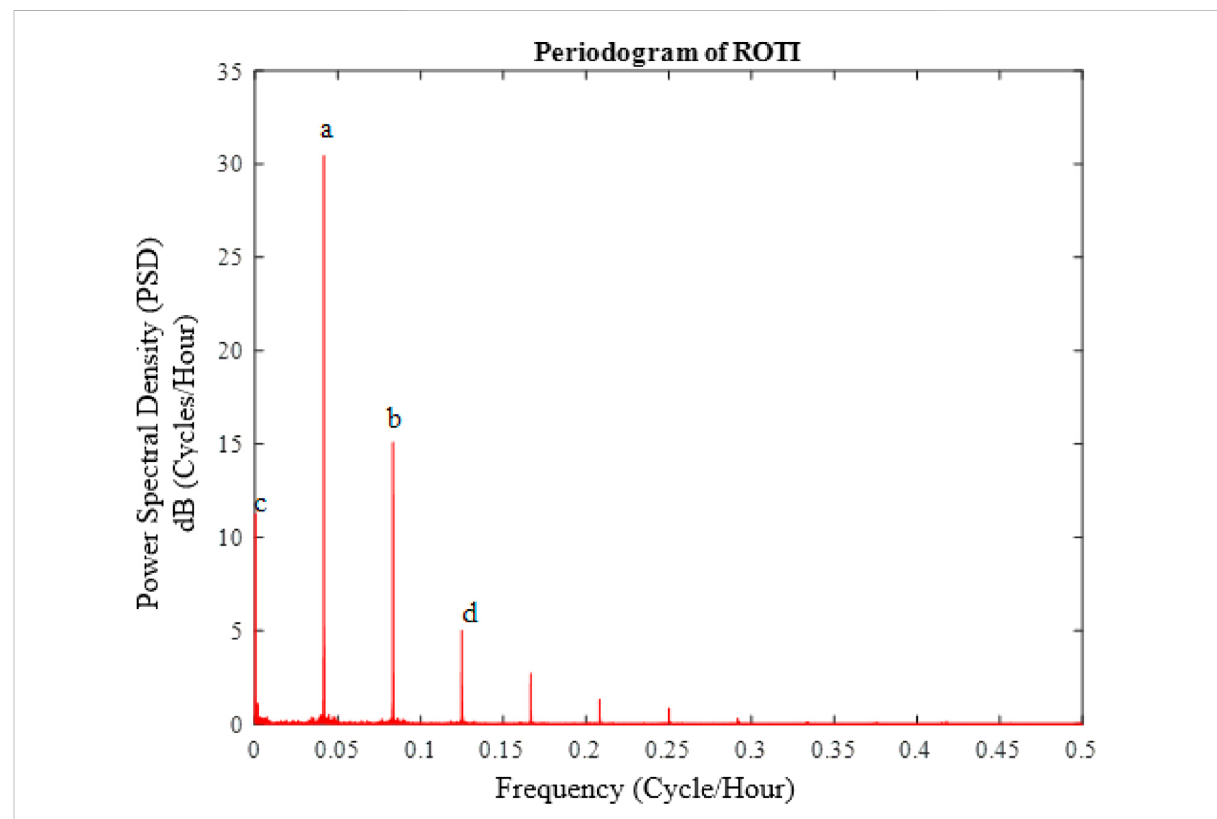
FIGURE 2 Periodogram of hourly ROTI values for the year 2012. The peaks marked (A – D) are, respectively, centered at 0.04169, 0.08331, 0.00024, and 0.12500 cycles/hour.